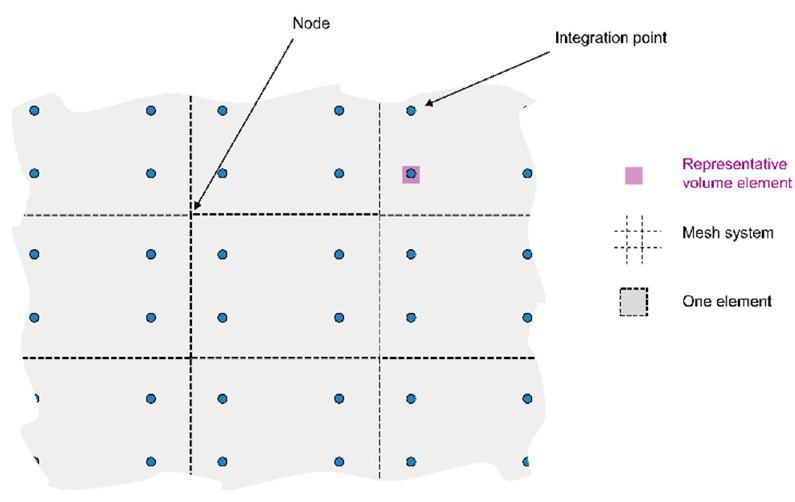
Figure 3. Schematic illustration of density type of model.